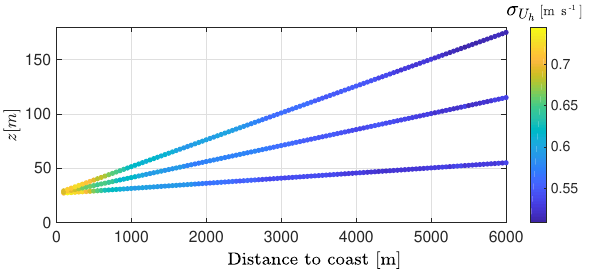
Figure 14. Time series of wind speed observations (Obs) and pre- dictions with the A, AH, AHR and AHRO models for period 7. Figure 15.